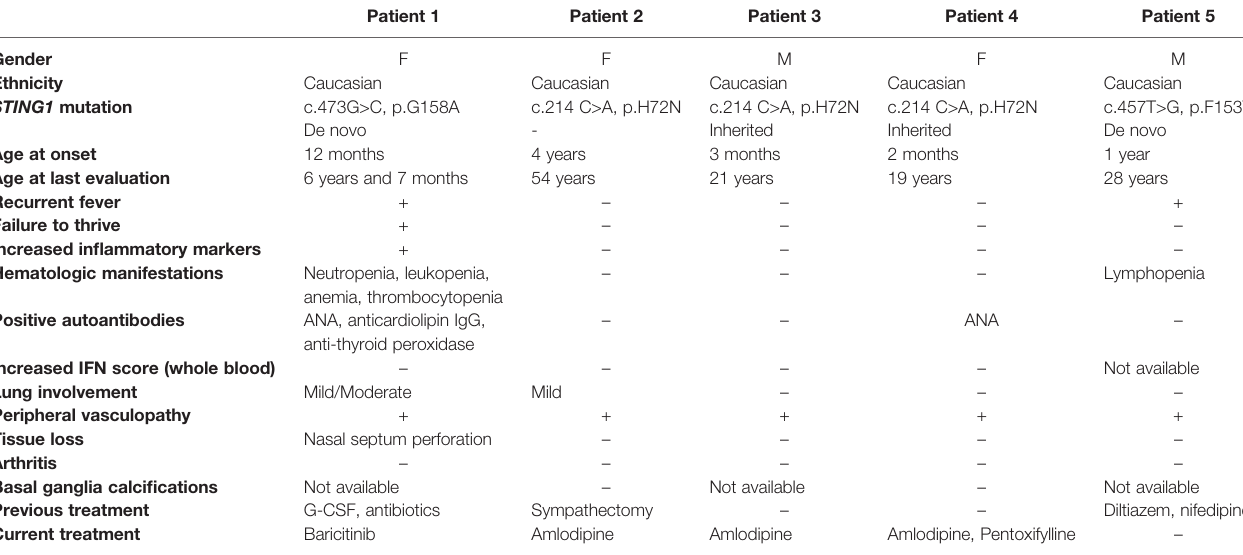
TABLE 1 | Patient